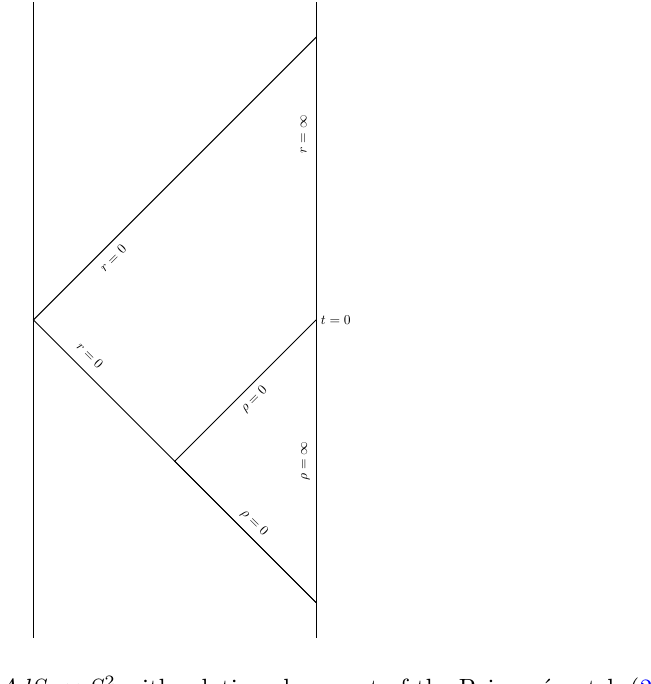
Figure 1 . Penrose diagram of AdS 2 × S 2 with relative placement of the Poincaré patch (2.2) and the Rindler patch (3.7) according to the transformation